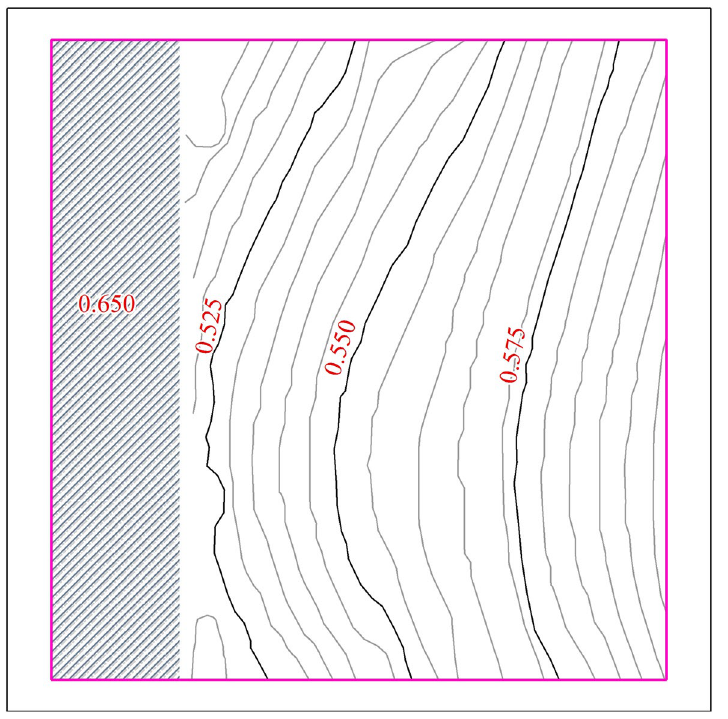
Figure 4. Terrain contour in study